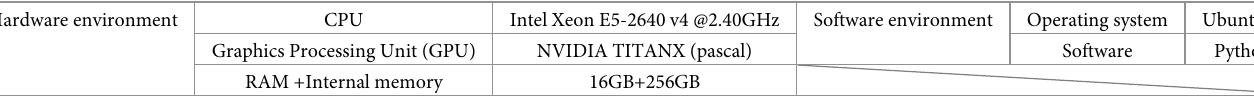
Table 2. Experimental hardware and software environment. Hardware